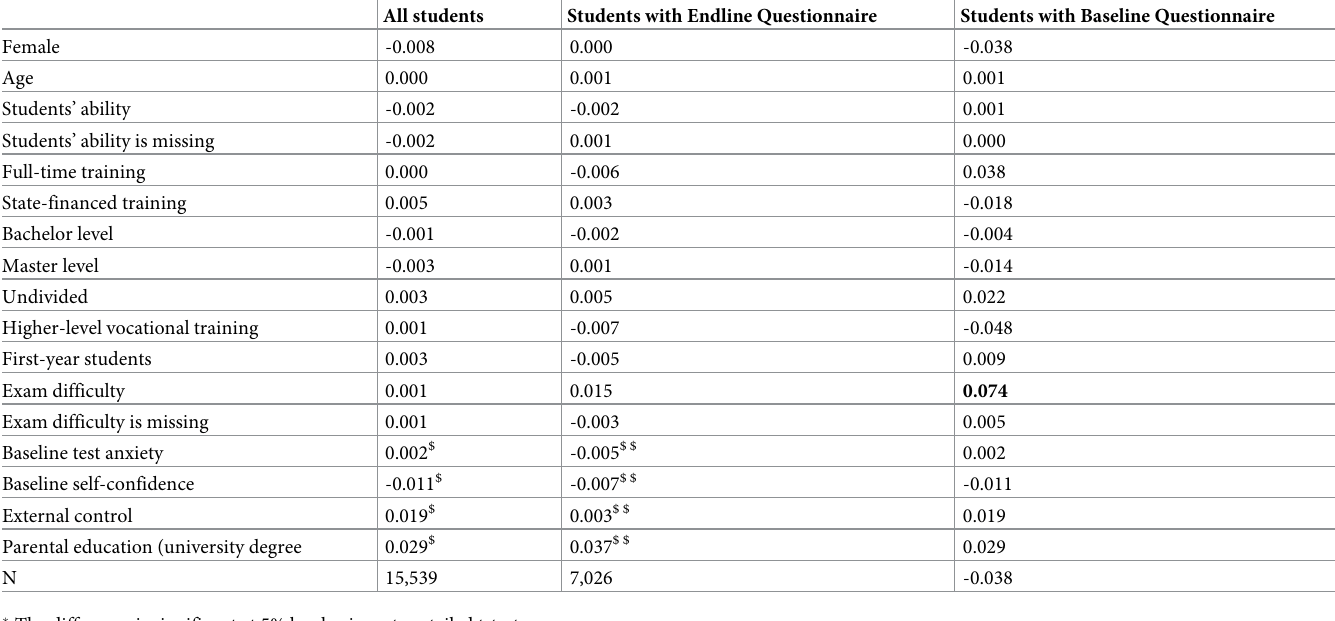
Table 1. Balance test. The difference in means between students allocated to Group A relative to Group B for each baseline covariate separately. All students Students with Endline Questionnaire Students with Baseline